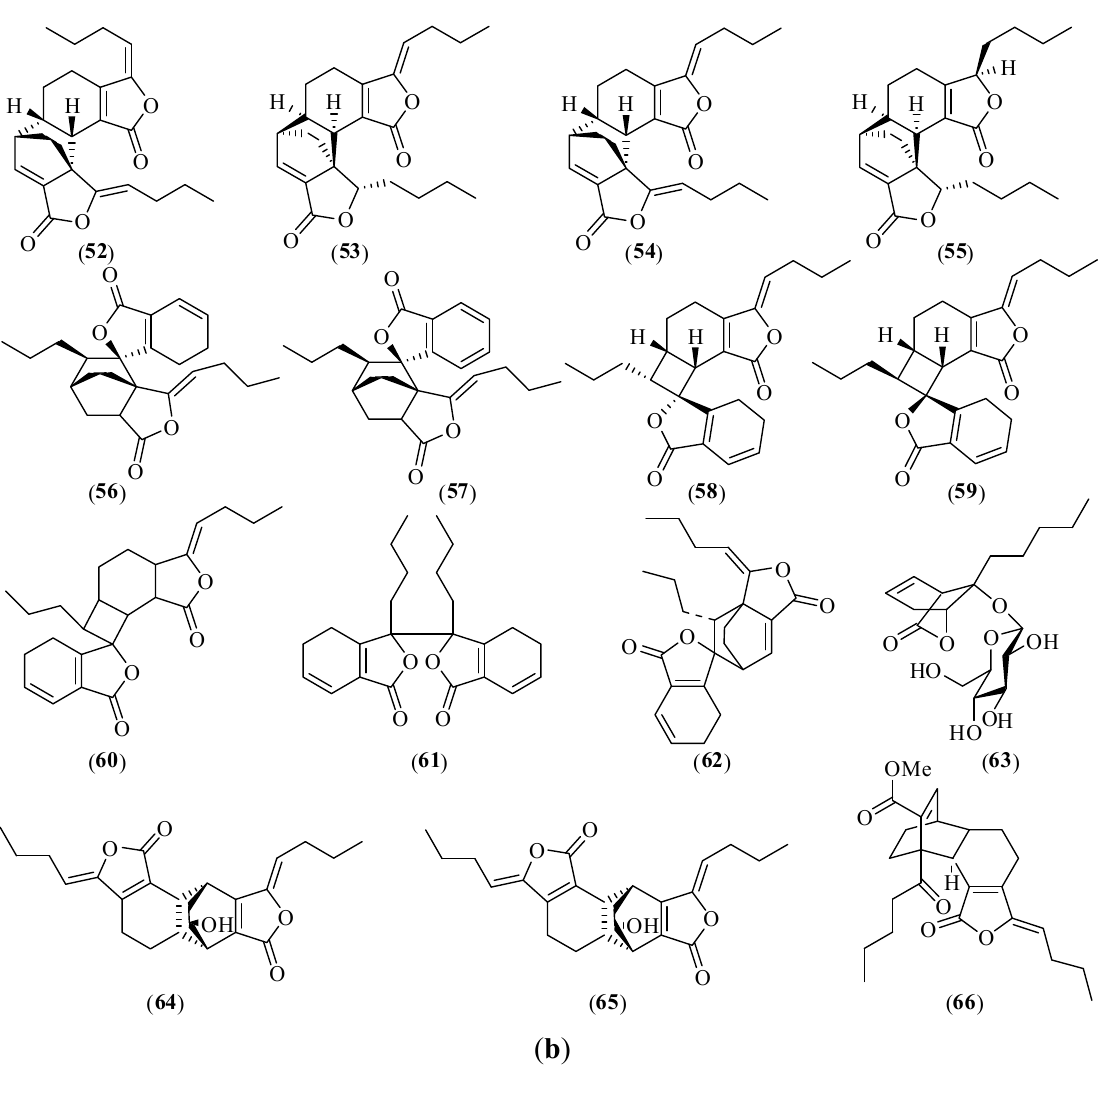
Figure 2. Cont. Chemical structures of main phthalide dimers in CX: ( 52 ) senkyunolide O; ( 53 ) senkyunolide P; ( 54 ) levistolide A; ( 55 ) 3,8-dihydrodiligustilide; ( 56 ) tokinolide B; ( 57 ) ansaspirolide; ( 58 ) riligustilide; ( 59 ) ( Z , Z' )-6,8',7,3'-diligustilide; ( 60 ) angelicide; ( 61 ) Z , Z' -3,3',8,8'-diligustilide; ( 62 ) Z -ligustilide dimer E-232; ( 63 ) ligusticoside A; ( 64 ) chuanxiongnolide A; ( 65 ) chuanxiongnolide B; ( 66 )